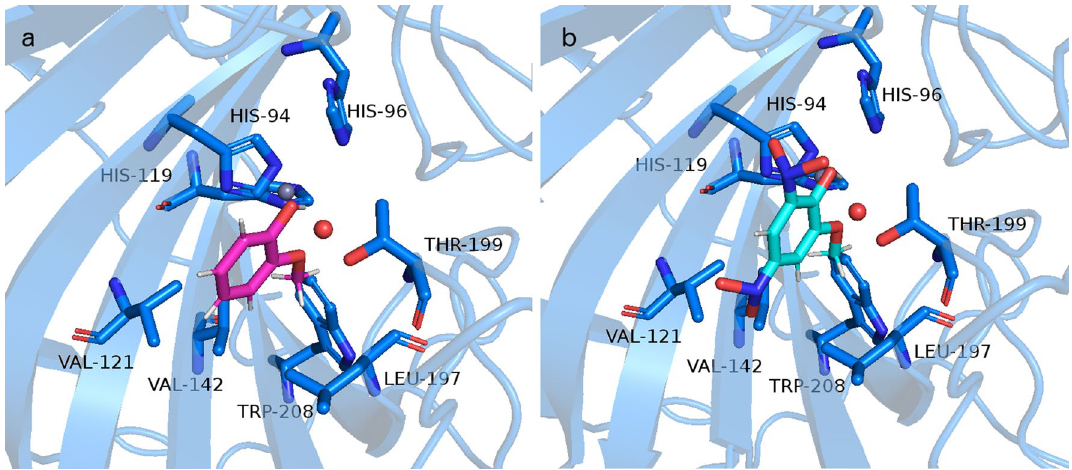
Figure 5. Representation of the interactions between ( a ) GUA and ( b ) 4,6DNG with the active site D. rerio CA II. Structure of D. rerio CA II (UniProt entry: Q92051) is modeled by I-TASSER, coordinates for Zn cation, and active site water molecule (oxygen atom in red) were taken from the structure of human CA deposited under PDB ID 1fql, whereas docking pose for GUA was obtained by SwissDock server. The same pose was obtained by AutoDock vina. Representation was made in PyMOL software (https ://pymol